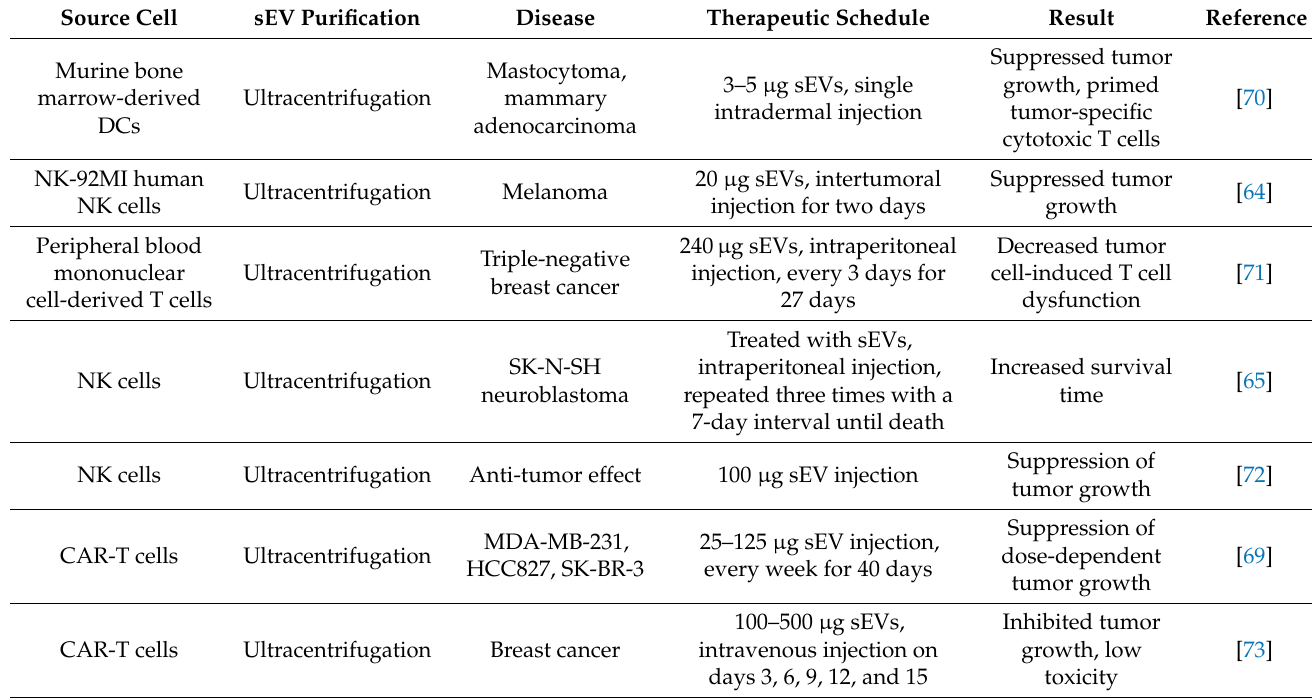
Table 3. Therapeutics using immune cell-derived naïve